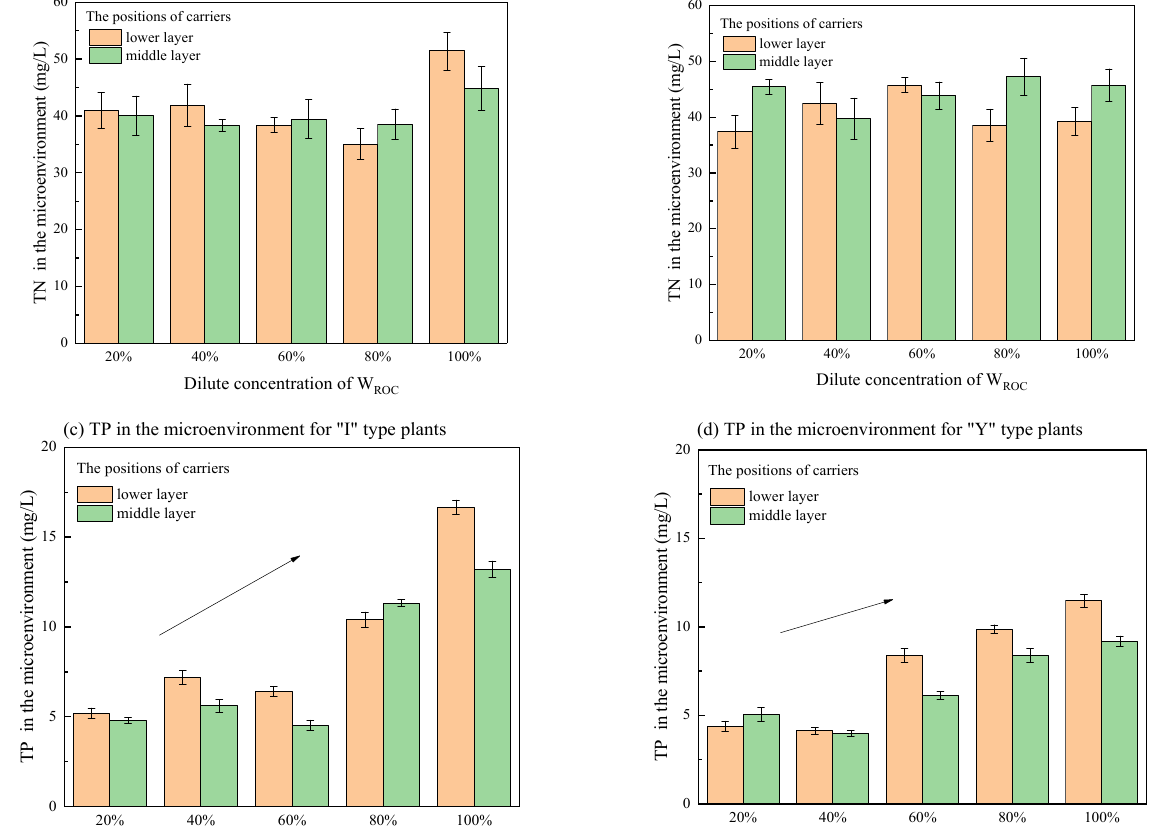
Figure 5. Total nitrogen and total phosphorus concentration in the micro − environment of the attached microalgae − simulated plant. ( a ) TN in micro-environment for “I” type plants; ( b ) TN in micro-environment for “Y” type plants; ( c ) TP in micro-environment for “I” type plants; ( d ) TP in micro-environment for “Y” type plants.